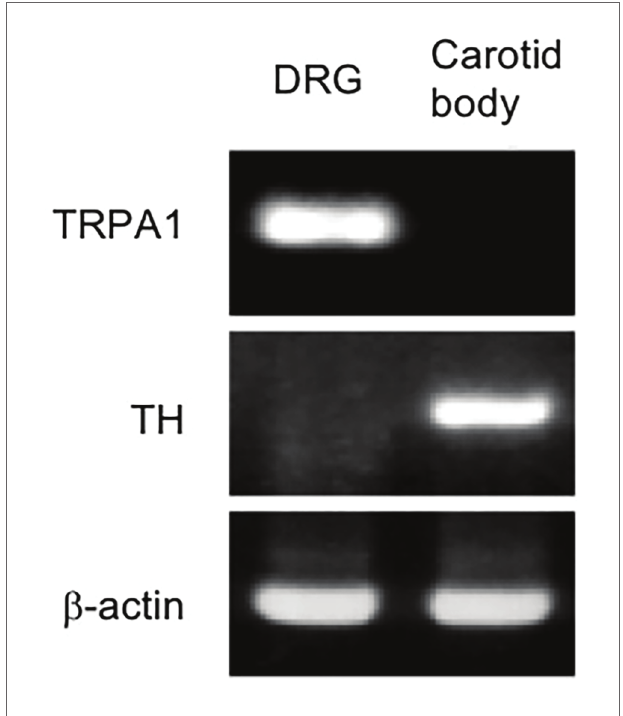
FIGURE 6 | RNA expression of TRPA1 was undetectable in the mouse carotid body. RNAs are subjected to RT-PCR from the mouse carotid body and that from dorsal root ganglia (DRG) as a positive control of TRPA1 expression. Identification of carotid body is confirmed by the detection of tyrosine hydroxylase (TH) RNA, a specific marker for carotid body in the carotid artery region. A similar result was obtained in two